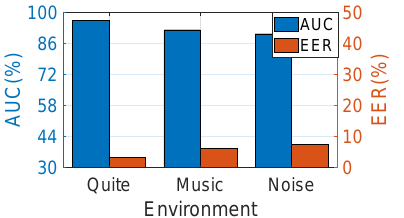
Figure 15. The AUC and EER under difference noise